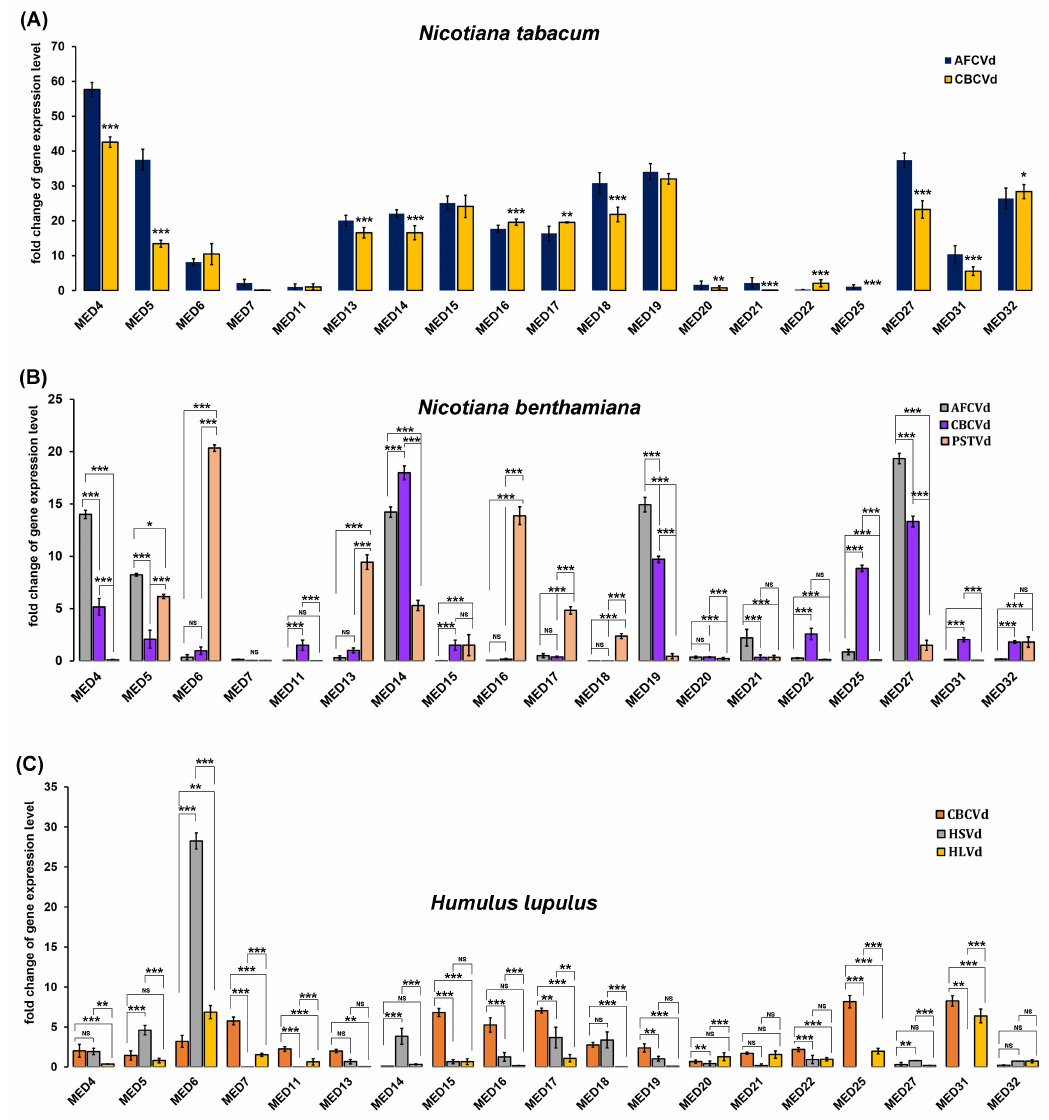
Figure 2. Reverse transcriptase quantitative real-time PCR (RT-qPCR)-based expression profiling of selected mediator subunits in response to the viroid infection in N. tabacum ( A ), N . benthamiana ( B ) and hop ( C ) plants. RT-qPCR analyses were normalized using DRH1 as an internal control gene and the fold change in each gene in viroid infected / transformed plants was calculated with respect to mock-inoculated control plants by the (2 − ∆∆ Ct ) method. The data were obtained from three independent experiments; bars show ± SD. Comparison between groups was assessed by a two-way ANOVA followed by Tukey’s test, an asterisk denotes statistically significant di ff erences (* p < 0.1, ** p < 0.05, and *** p <